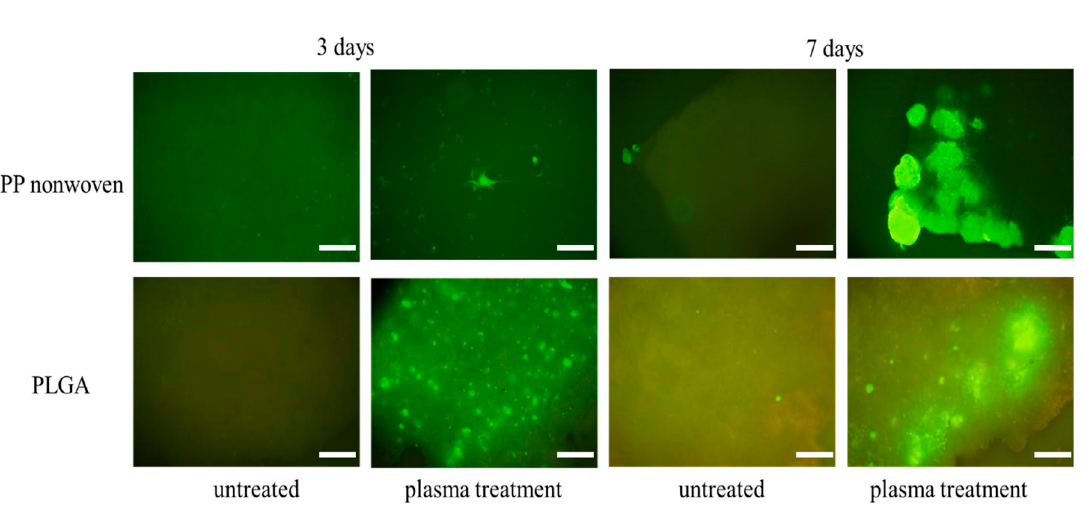
Figure 5. After acetic acid plasma treatment, embryonic stem (ES) cells on the PP nonwoven and PLGA was observed using fluorescence microscopy. Scale bars represent 50 μ m.